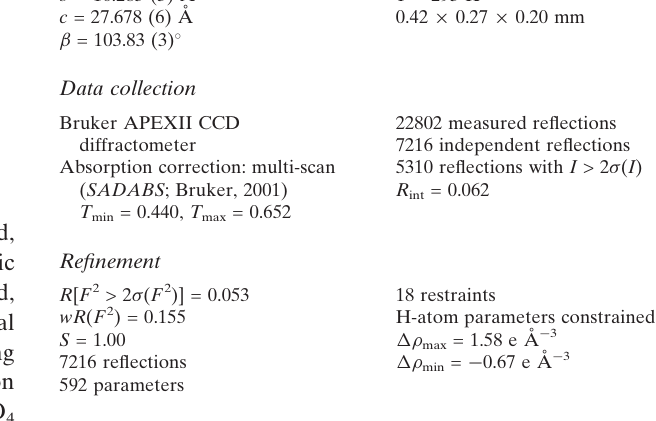
Data collection Bruker APEXII CCD diffractometer Absorption correction: multi-scan ( SADABS ; Bruker, 2001)